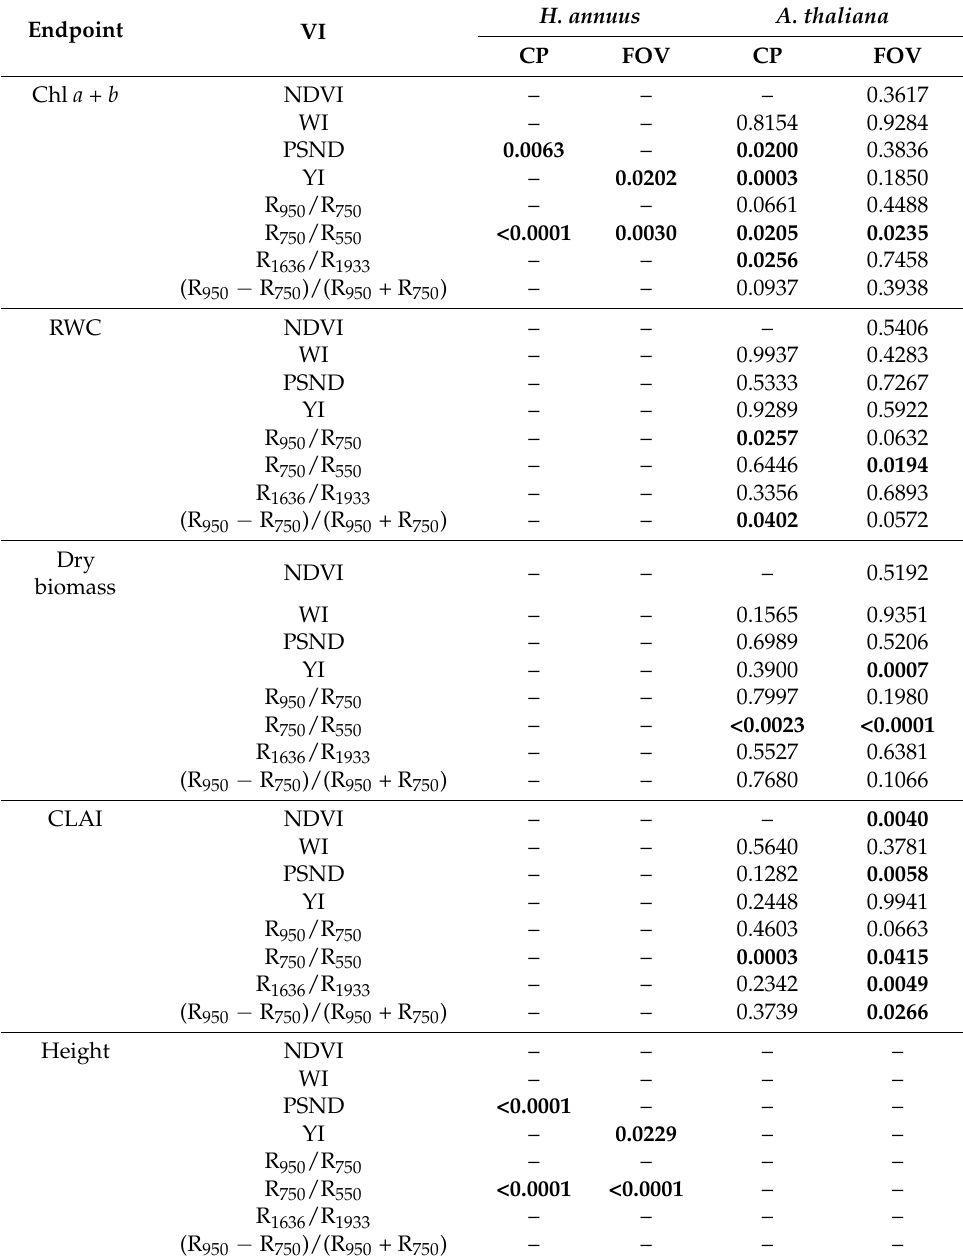
Table 2. Results of secondary mixed-effects analysis. Significant p -values shown in